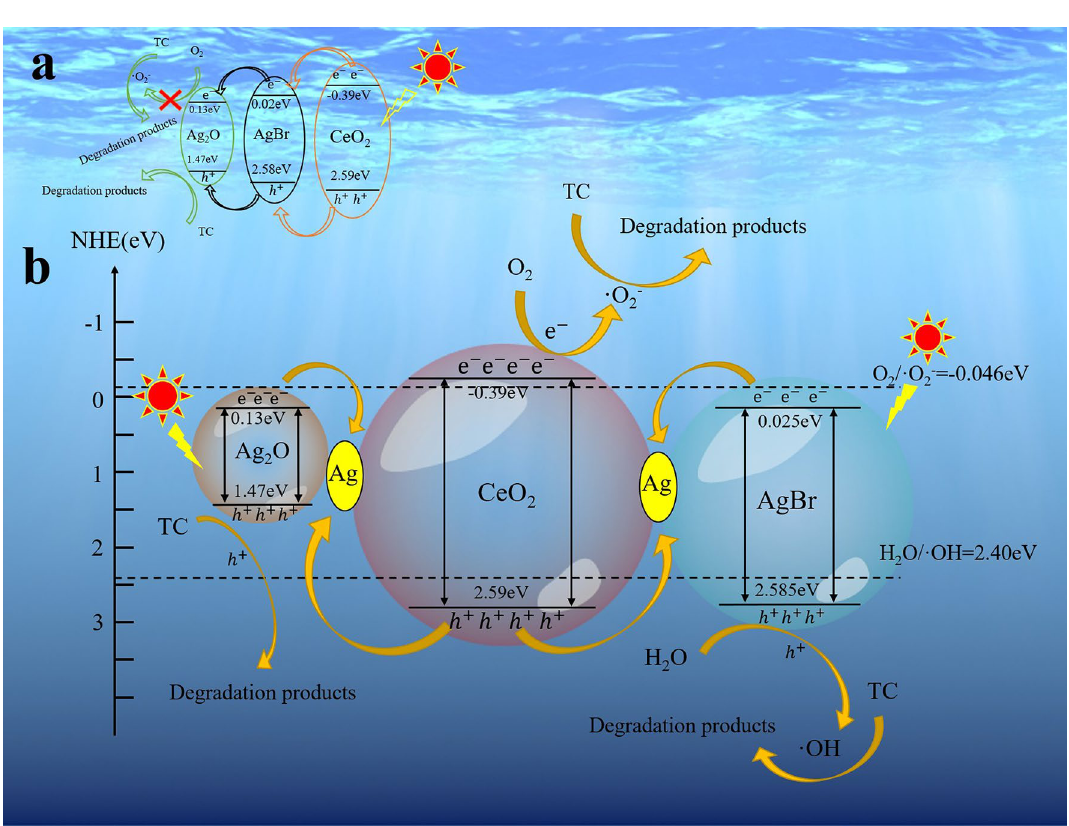
Figure 8. Schematic illustration of the proposed reaction mechanism for TC degradation under visible light irradiation based on the ( a ) conventional heterojunction; ( b ) double Z-scheme